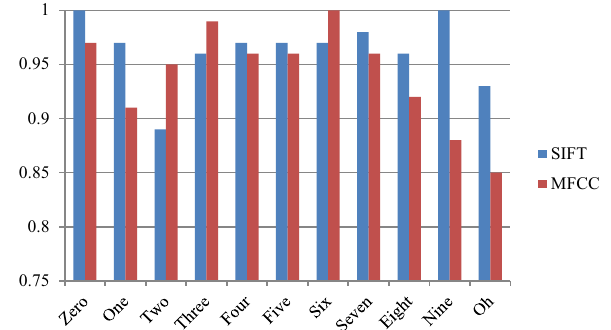
Fig. 7 Correct classification rate of LNBNN with MFCC and SIFT features on the English digits